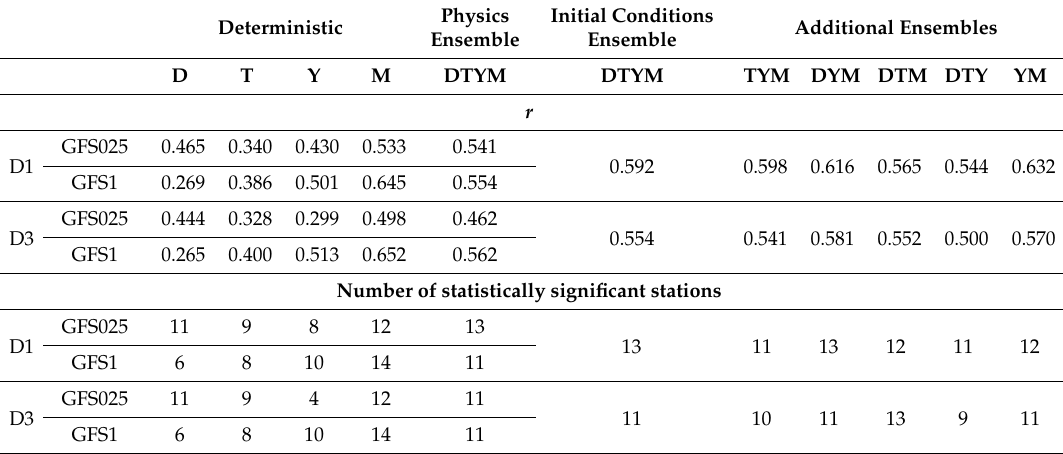
Table 5. Temporal validation: r and number of statistically significant stations. All 32 model configurations are shown for domain resolution, GFS resolution, microphysics parameterizations, and various ensembles chosen. All r values are statistically significant. Best three performers for each index are